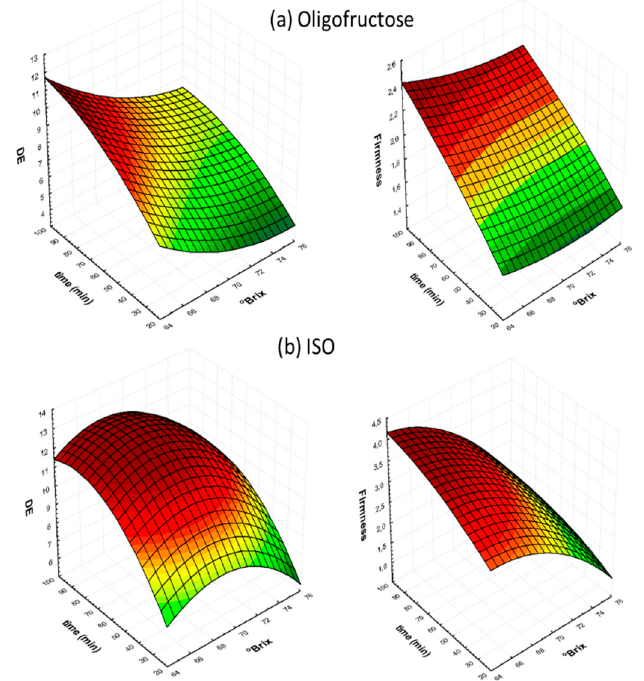
Figure 3. Three-dimensional Response Surface graphs for color change ( ∆ E) and firmness, as a function of process duration and OD solution concentration, at a fixed temperature of 85 ◦ C, in the case of: ( a ) O and ( b ) ISO osmotic solutions.